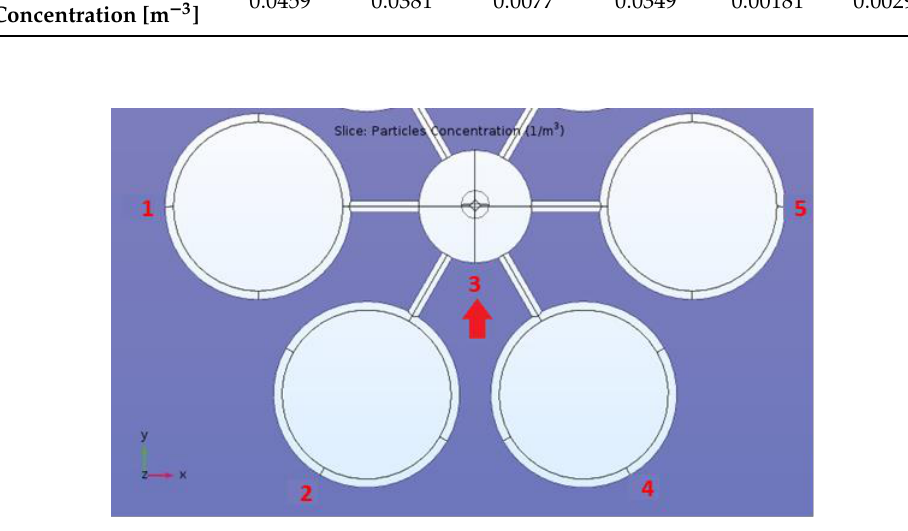
Figure 10. Reference points for the particle concentration comparison in the case of Nadir, Radial and Zenith solutions. Table 5. Particle concentration for the Nadir, Radial and Zenith configuration comparison.